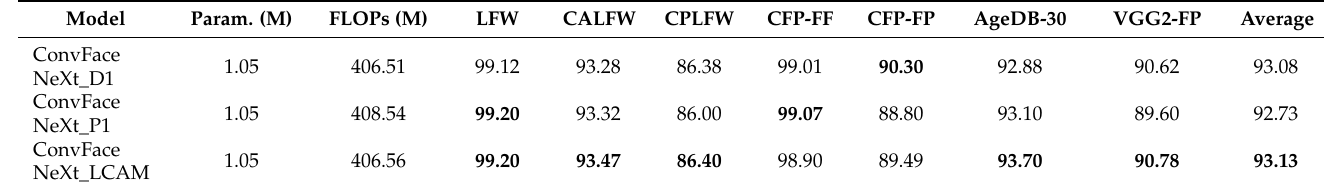
Table 5. Performance results on different integration strategies. These results are reported in terms of parameters, FLOPs, and verification accuracy for LFW, CALFW, CPLFW, CFP-FF, CFP-FP, AgeDB-30, and VGG2-FP. Moreover, the average accuracy for the seven image-based datasets is shown in the last column. (Bold values are the highest obtained values by the methods).